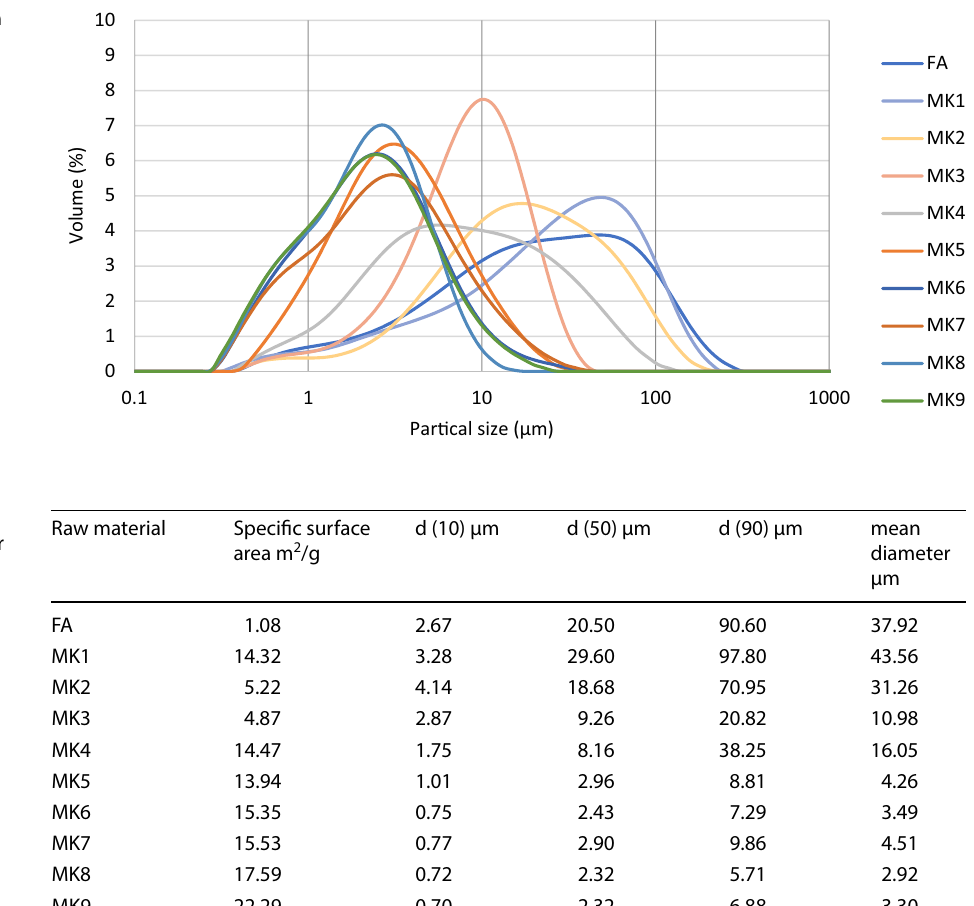
Fig. 1 Particle size distribution of the FA and MK